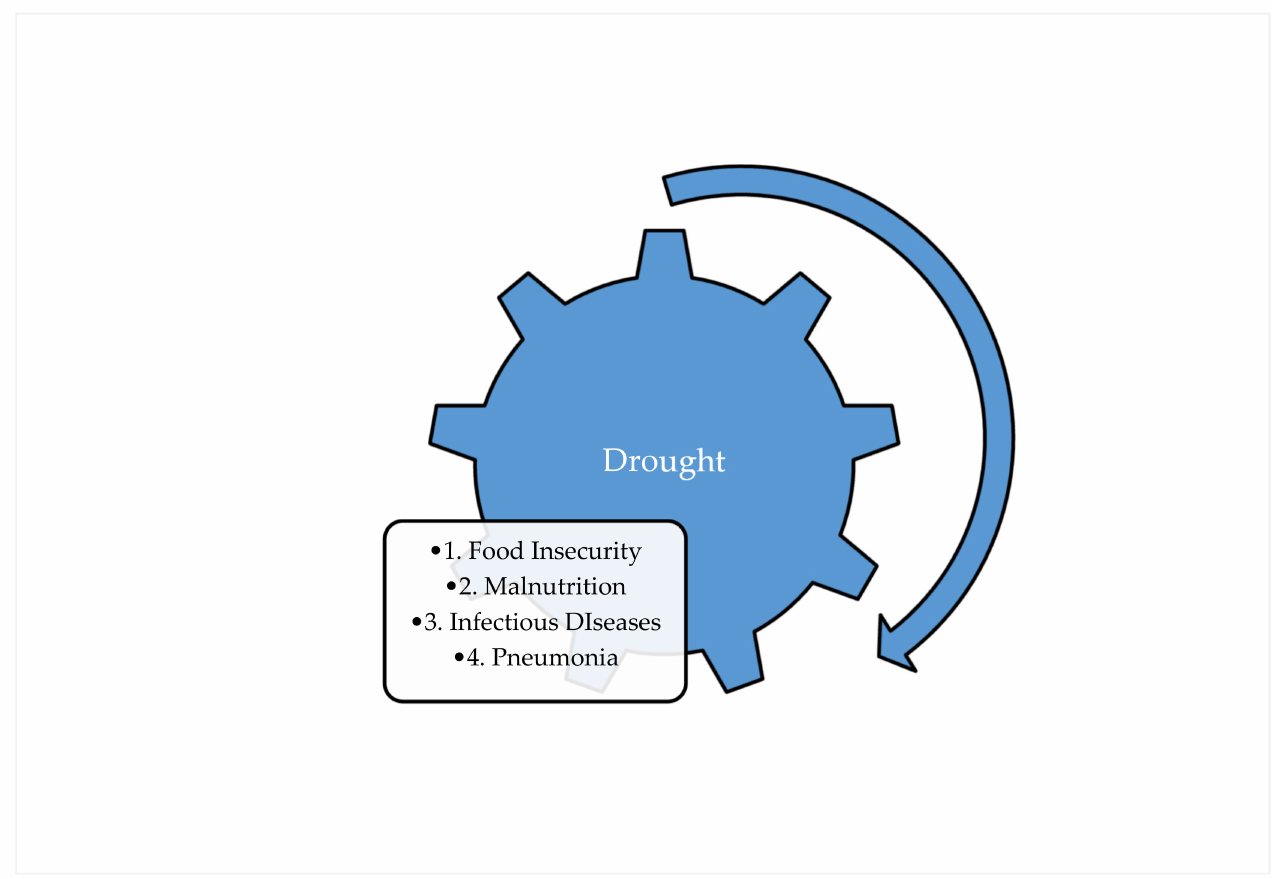
Figure 1. The ‘Drought’ framework proposed by the World Health Organization with four key covariates.